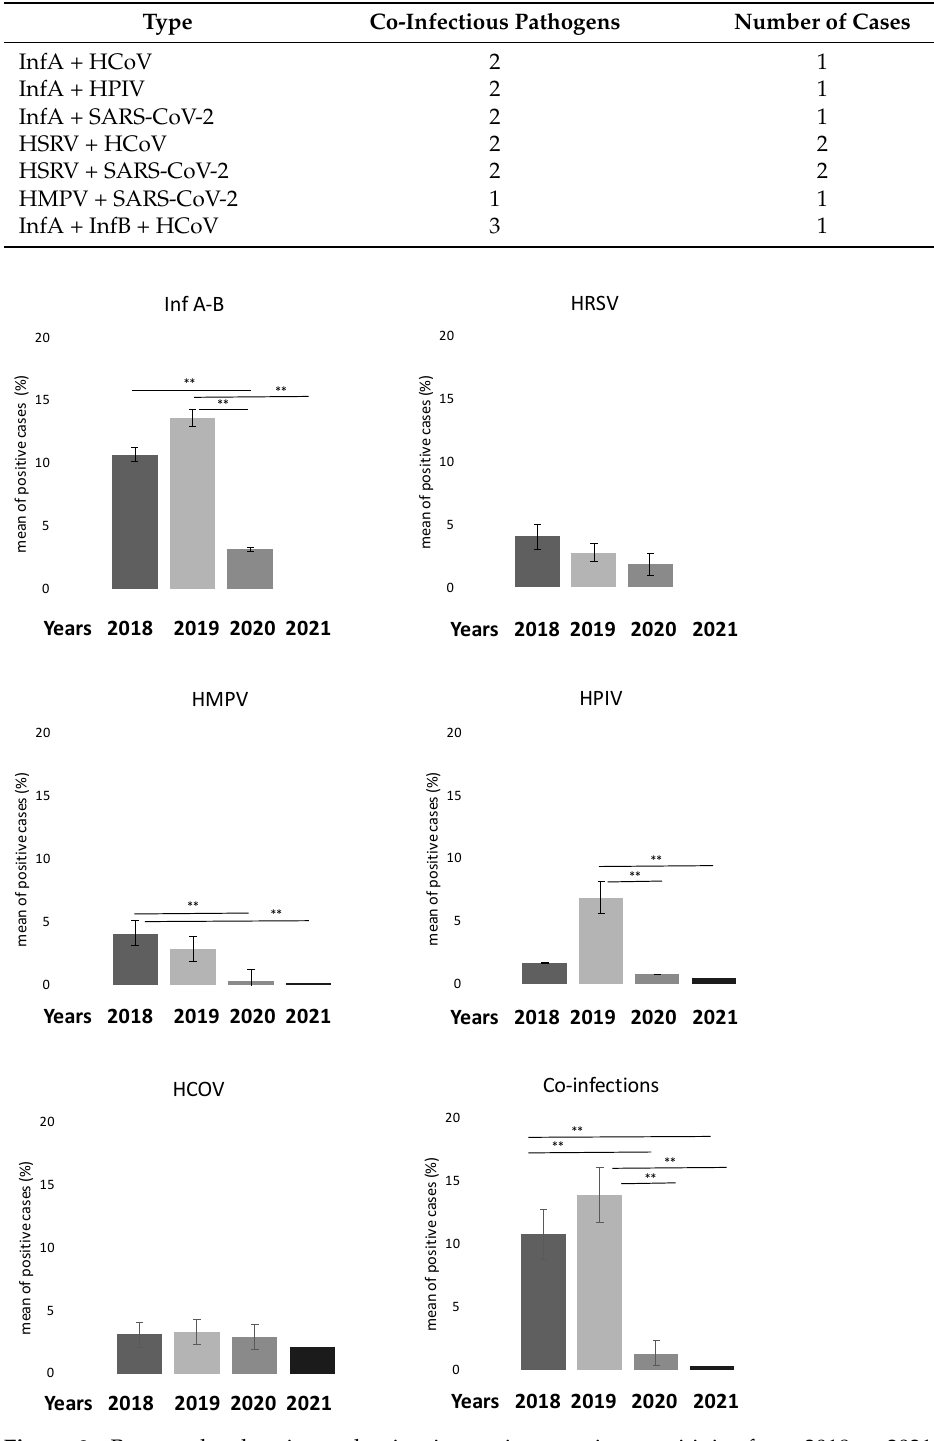
Figure 3. Bar graphs showing reduction in respiratory virus positivity from 2018 to 2021. Co-infection rate also decreased. ** p < 0.001 for ANOVA Bonferroni test. Abbreviations: HCoV: Human Coronavirus; HMPV: Human Metapneumovirus; Inf A-B: Influenza virus A-B; PIV: Parainfluenza virus; RSV: Respiratory Syncytial Virus.